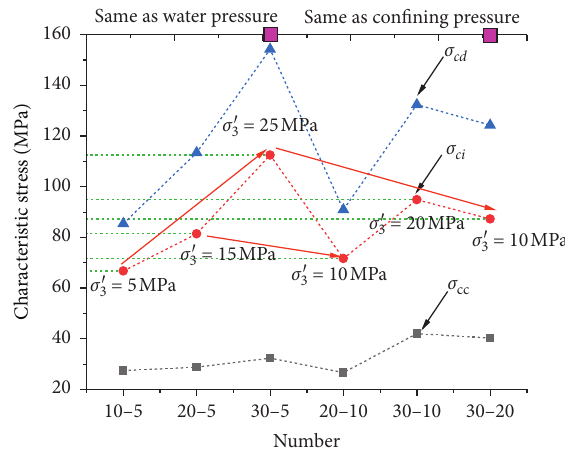
Figure 10: Variation law of characteristic stress under different confining pressure and pore water pressure conditions.